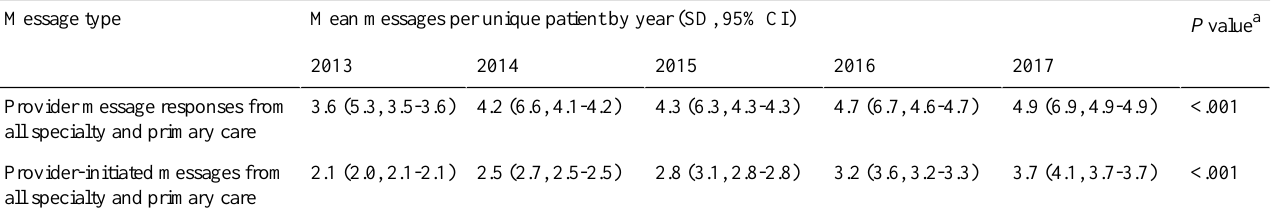
Table 2. Messages per unique patient by